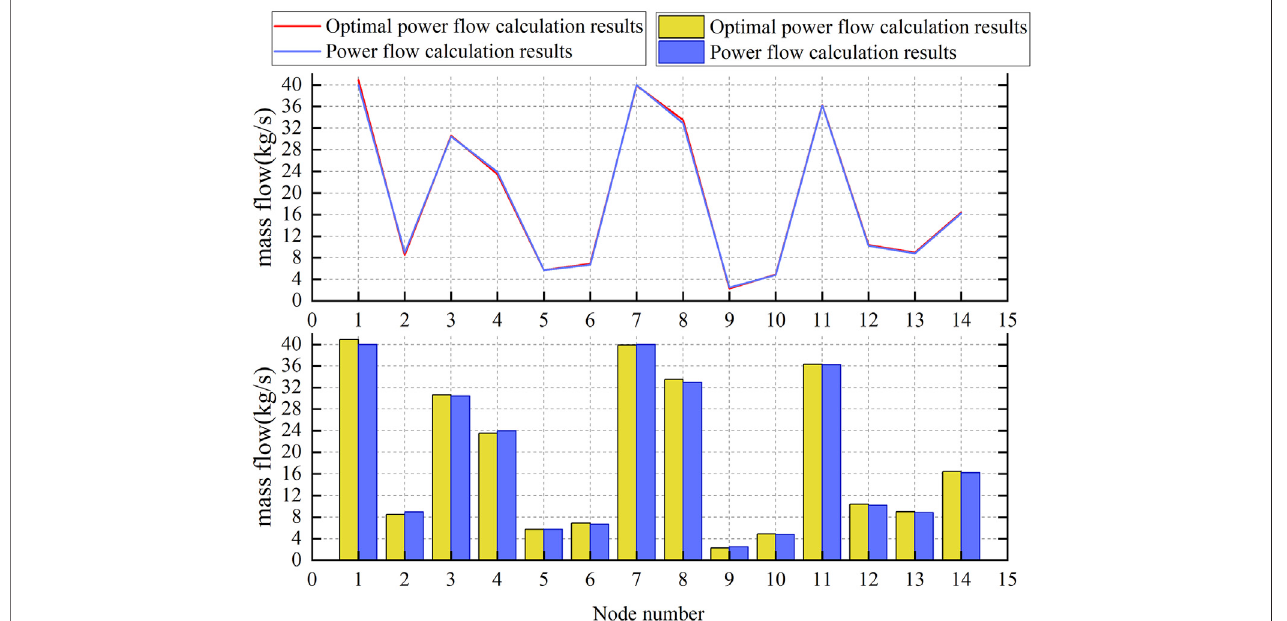
FIGURE 6 | Comparison chart of pipeline fl ow calculation results.